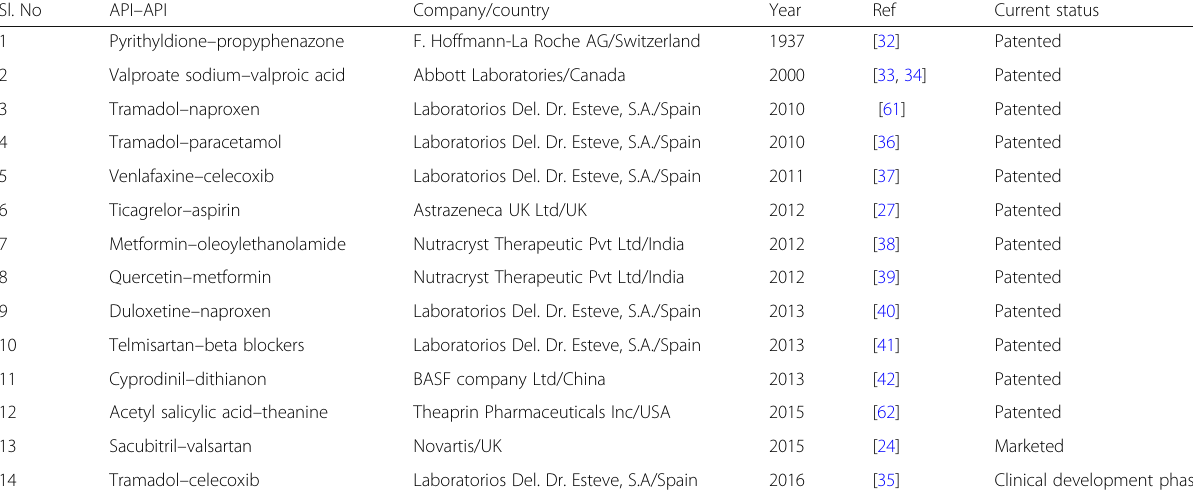
Table 1 List of drug – drug cocrystals patented and clinical development